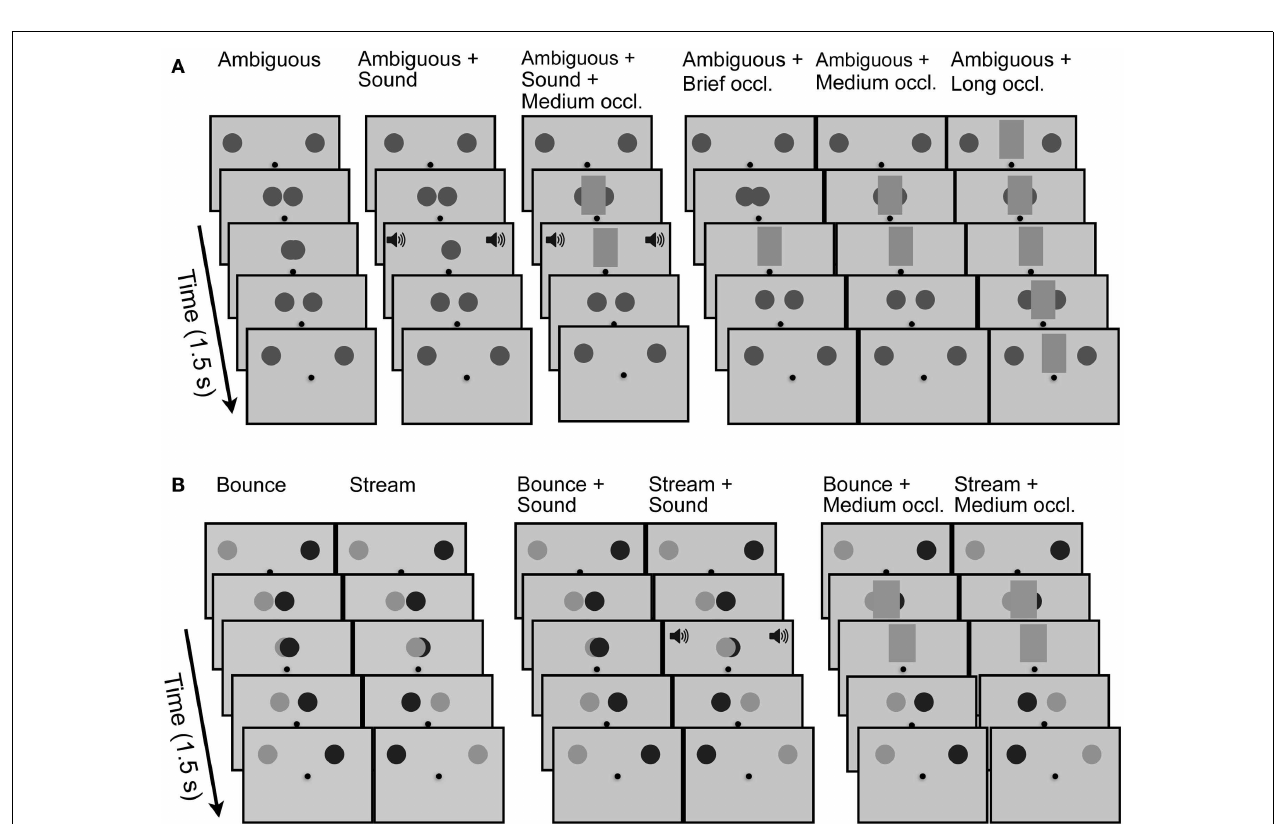
Ambiguous + Long occluder : the location at which the disks would coincide is obscured by opaque occluder presented for 1.5s, that is, the entire duration of the moving stimulus. (B) Key events in the six conditions that promoted unambiguous motion.Two disks of unequal luminances moved toward each other, coincided, and then either returned to their respective starting locations (promoting a percept of bouncing; shown in sequence 1) or continued to the opposite side of the display (promoting a percept of streaming; shown in sequence 2). In sequences 3 and 4, at the moment of the disks’ coincidence, a click sound was inserted into a stimulus that promoted bouncing (sequence 3) or one that promoted streaming (sequence 4). In the final two sequences, a 0.233-s occluder was inserted into a sequence that promoted bouncing (sequence 5) or one that promoted streaming (sequence 6).